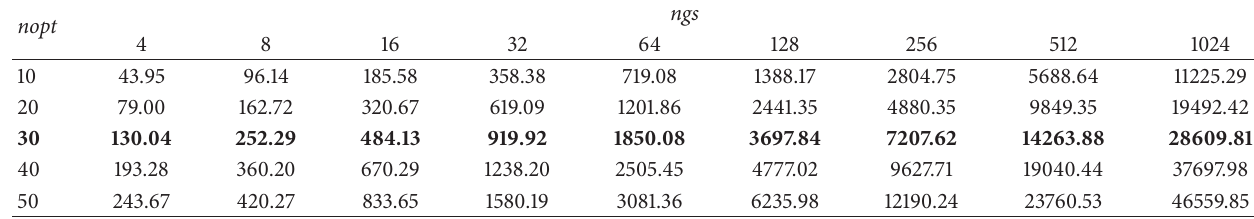
Table 1: Total execution time (seconds) of the Serial-SCE-UA.